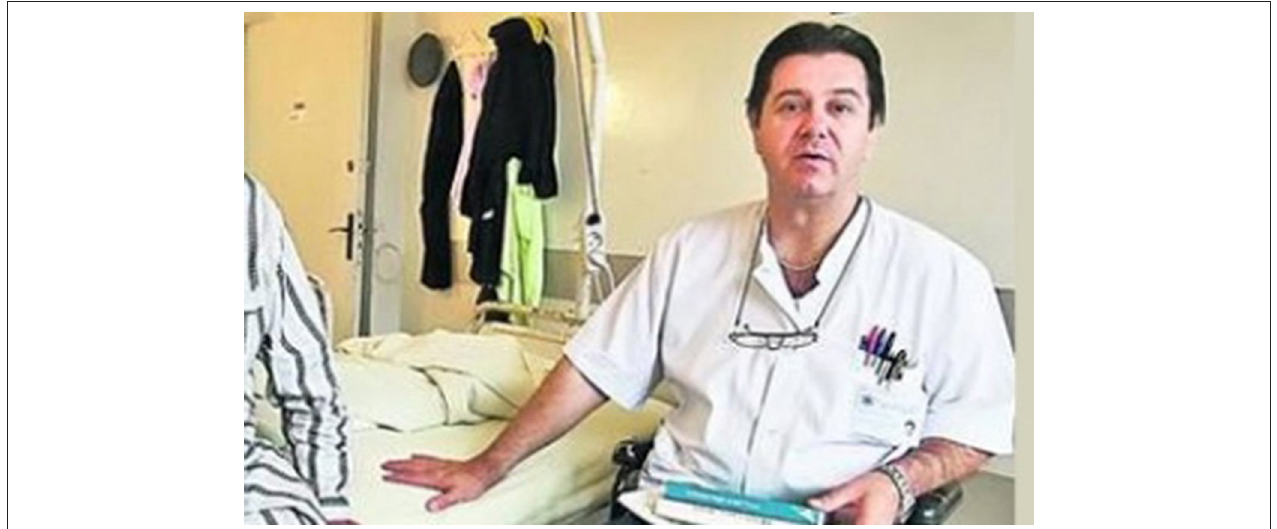
FIGURE 1 | The picture of the first author Prof. Dr. Gelu Onose in wheelchair visiting patients in the NeuroRehabilitation Clinic Division of the ‘Bagdasar-Arseni’ Teaching Emergency Hospital, Bucharest, Romania. Reproduced with permission of the TV producer, Romanian